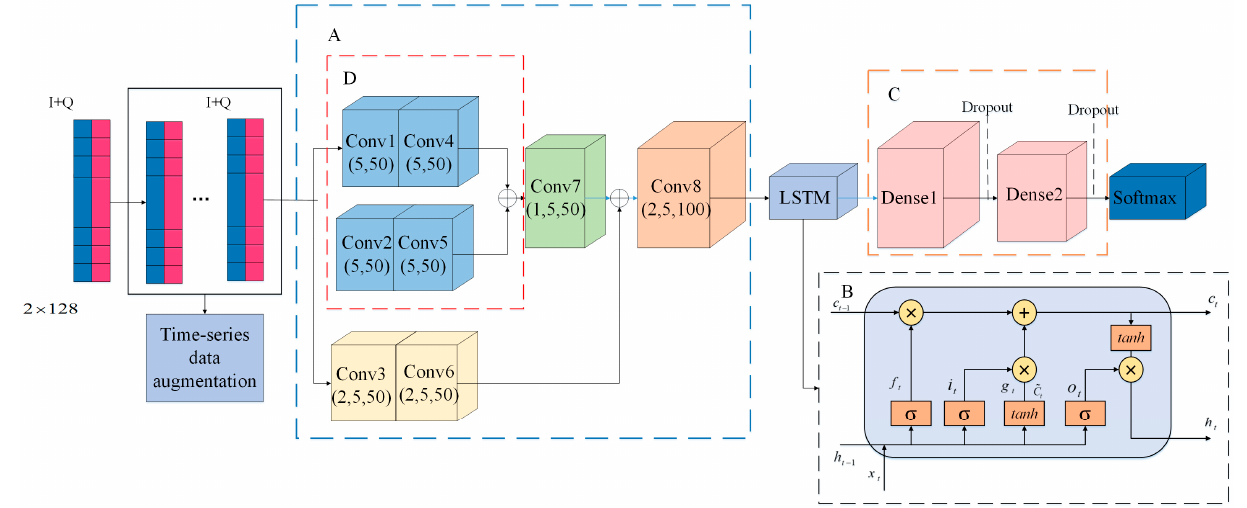
Figure 3. Spatiotemporal multi-channel network framework diagram.